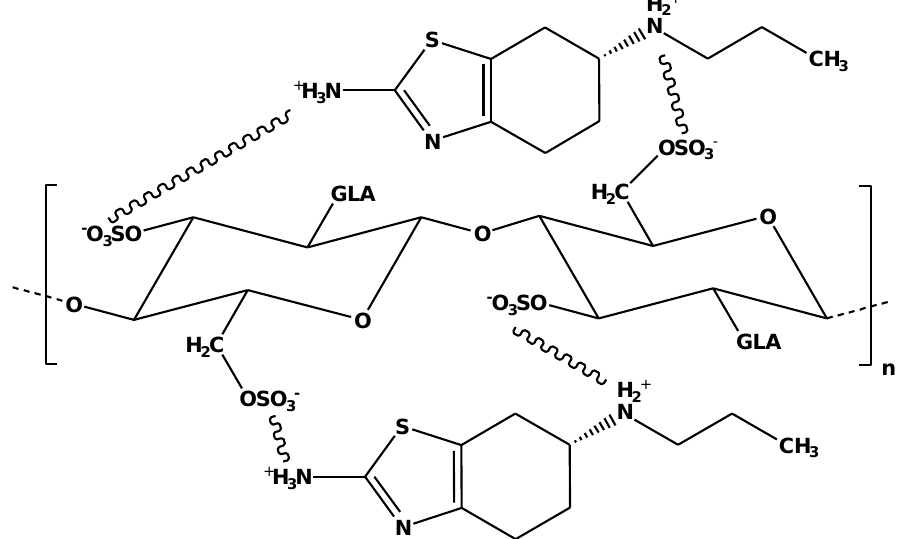
Figure 8. Interactions between CsSLF and PRM molecule [32]. Figure 14. Interactions between CsSLF and PRM molecule [32].